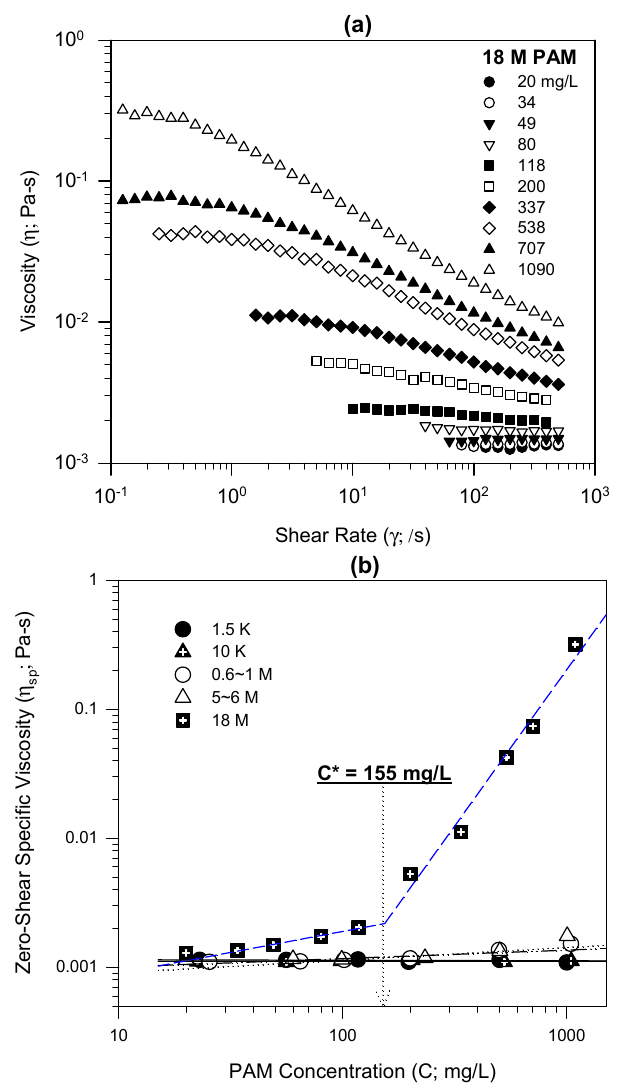
Figure 2. Experimental results of steady-shear viscosity measurements: ( a ) steady-shear viscosity versus shear rate at different polyacrylamide (PAM) concentrations for 18 M PAM and ( b ) zero-shear specific viscosity versus PAM concentration for 1.5 K, 10 K, 0.6–1 M, 5–6 M, and 18 M